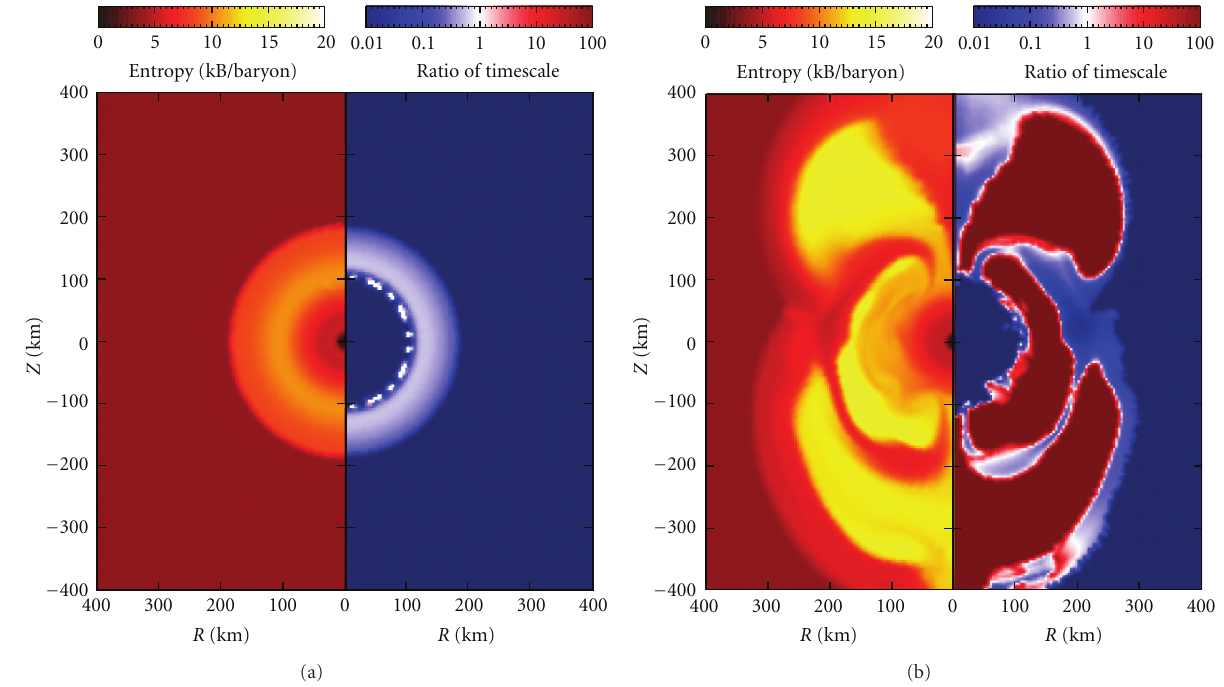
Figure 2: Snapshot of the distribution of entropy (left half) and the ratio of the advection to the heating timescale (right half) for models of the 1D (left) and 2D (right) models at 200 ms after bounce. These figures are taken from [138].